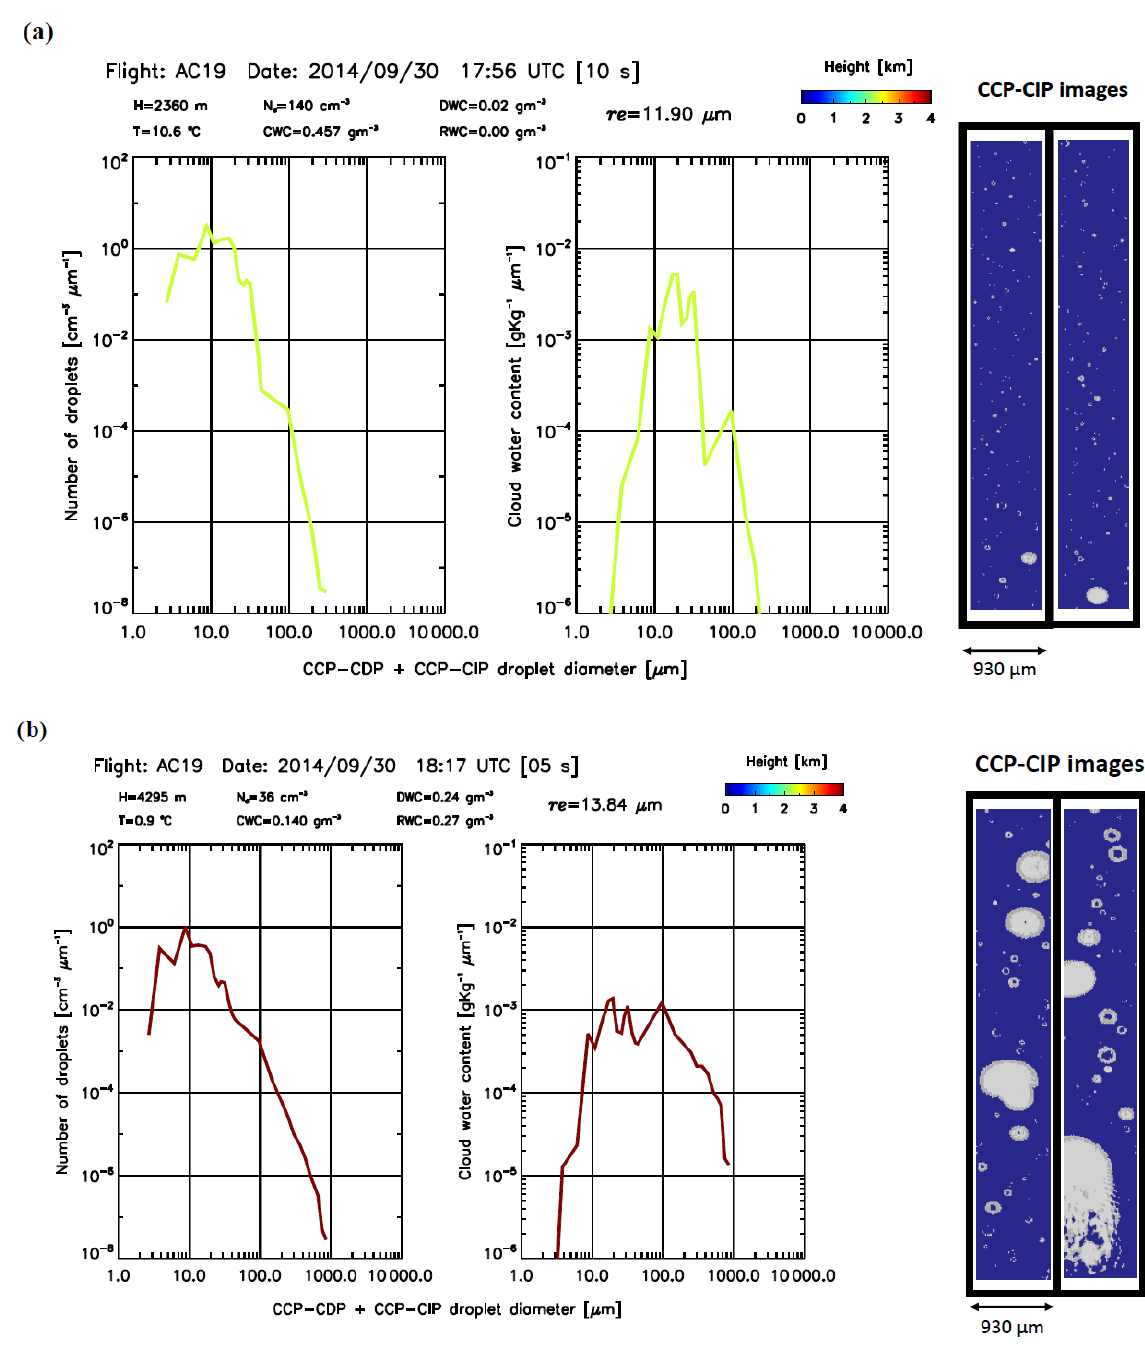
Figure 9. (a, b) Similar to Fig. 5a–c for flight AC19.